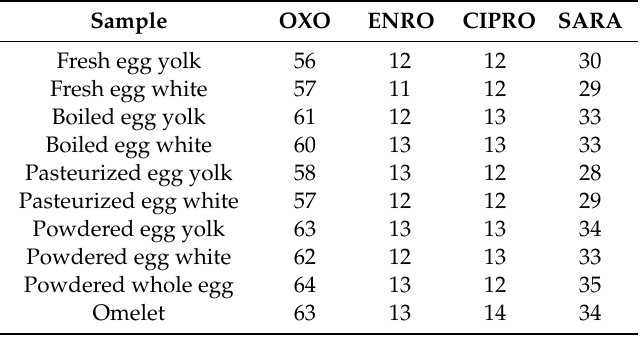
Table 4. Detection capacity for each quinolone in the studied meats (concentrations in µ g / kg). Sample